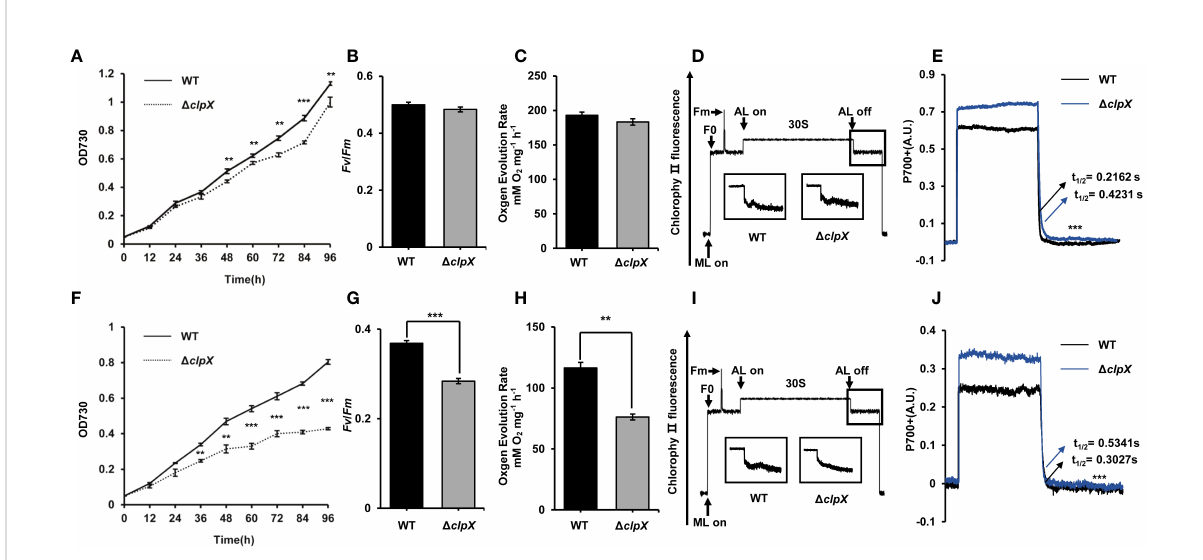
FIGURE 2 Functional effects of clpX in Synechocystis. (A) Growth curves of the wild type (WT) and D clpX strains under normal light (NL). (B) Measurement of maximum photochemistry ef fi ciency ( Fv / Fm ) of the WT and D clpX strains under NL. (C) Measurement of oxygen evolution rates of the WT and D clpX strains under NL. (D) Analysis of the transient increase in chlorophyll fl uorescence after the termination of AL illumination of the WT and D clpX strains under NL. (E) P700 + reduction kinetics of the WT and D clpX strains in the presence of DCMU under NL. (F) Growth curves of the WT and D clpX strain under high light (HL). (G) Measurement of maximum photochemistry ef fi ciency ( Fv / Fm ) of the WT and D clpX strains under HL. (H) Measurement of oxygen evolution rates of the WT and D clpX strains under HL. (I) Analysis of the transient increase in chlorophyll fl uorescence after the termination of AL illumination of the WT and D clpX strains under HL. (J) P700 + reduction kinetics of the WT and D clpX strains in the presence of DCMU under HL. ML, measuring light; AL, actinic light. Data are presented as the mean ± SD from three independent experiments. Statistical signi fi cance was determined by two-sample Student ’ s t -test (**, p < 0.01; ***, p <